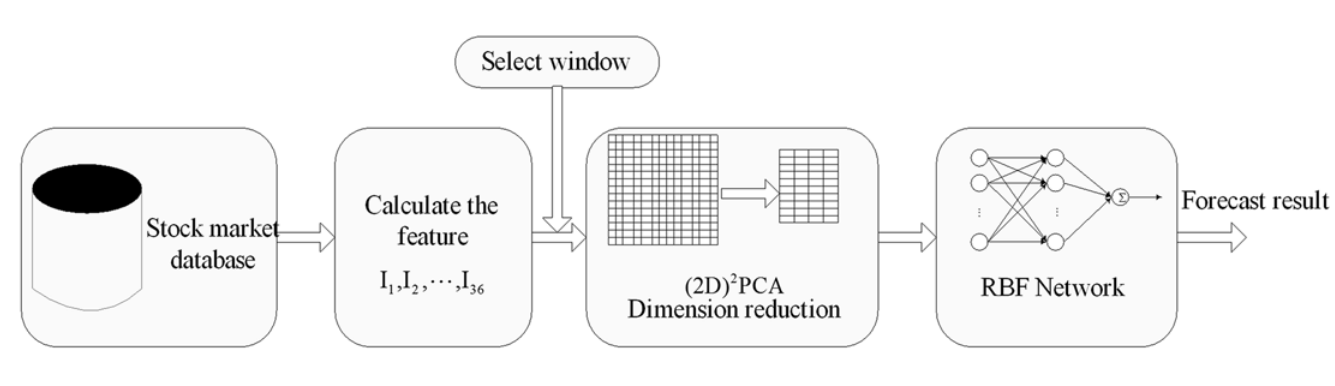
Fig 2. Diagram of (2D) 2 PCA+RBFNN forecasting model. The model is divided five modules, including the database of stock market, variables calculated module, sliding window, dimension reduction module and RBFNN predictor.